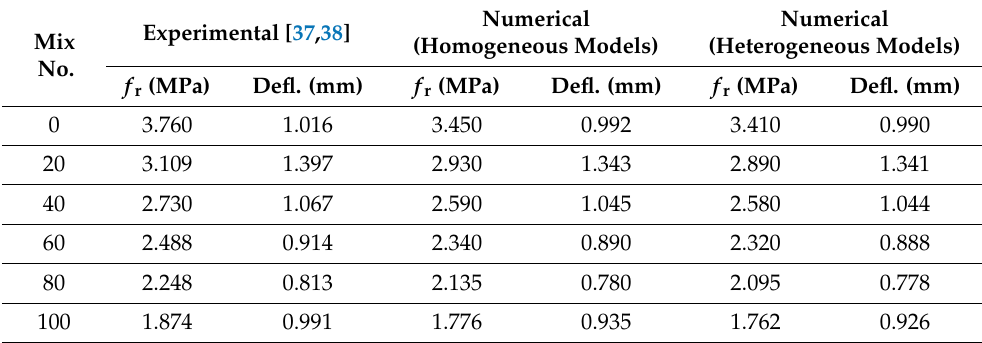
Table 3. Comparisons of the experimental and numerical results of the modulus of rupture and the mid-span deflection at failure loadings.